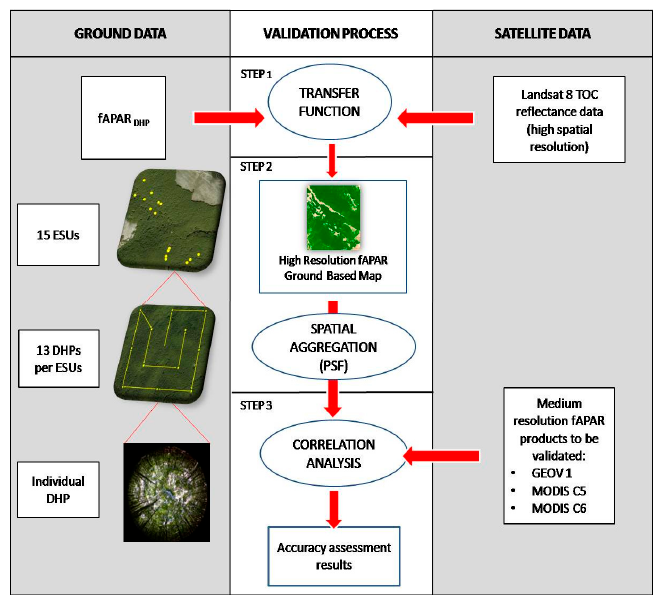
Figure 3. Bottom-up approach for the upscaling process used in the present study. 13 DHPs measurements were collected at every ESU and 15 ESUs were sampled over the site. Radiometric values over a decametric image (Landsat-8) were extracted over the ESUs and used to develop empirical transfer functions for upscaling the ESU ground measurements. The resulting high-resolution map was aggregated to the spatial resolution of the satellite product to be validated, taking into account the equivalent Point Spread Function (PSF) of the satellite sensors. A correlation analysis was performed to accomplish the accuracy